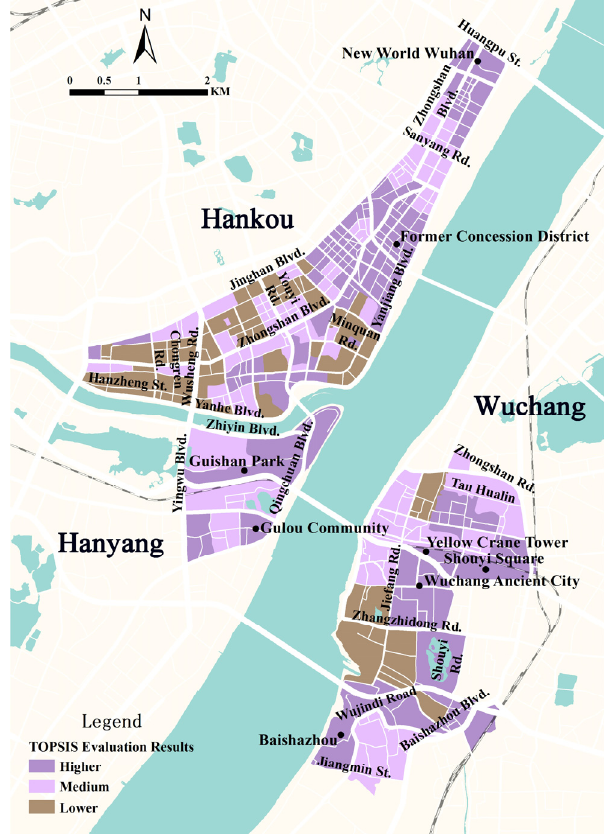
Figure 3. TOPSIS evaluation results.